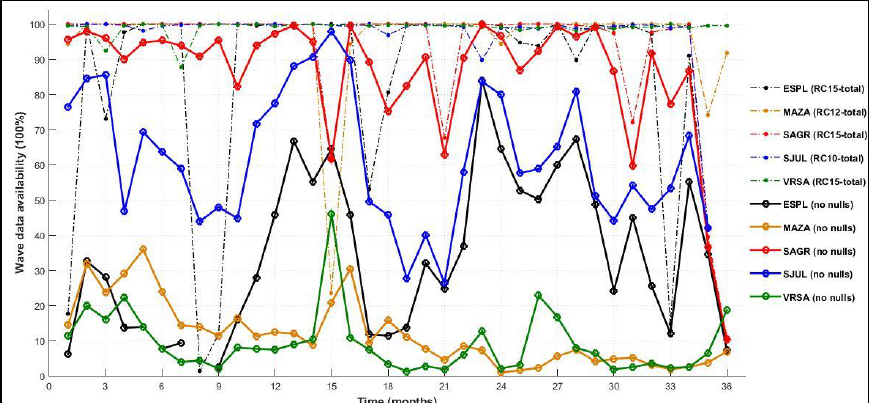
Figure 5. Availability of HFR wave data for the 12–13.5 MHz sites (36 months). Blue line: SJUL (RC10); blue dashed line: SJUL (no nulls); red line: SAGR (RC15); red dashed line: SAGR (no nulls); black line: ESPL (RC15); black dashed line: ESPL (no nulls); green line: VRSA (RC15); green dashed line: VRSA (no nulls); orange line: MAZA (RC12); orange dashed line: MAZA (no nulls).